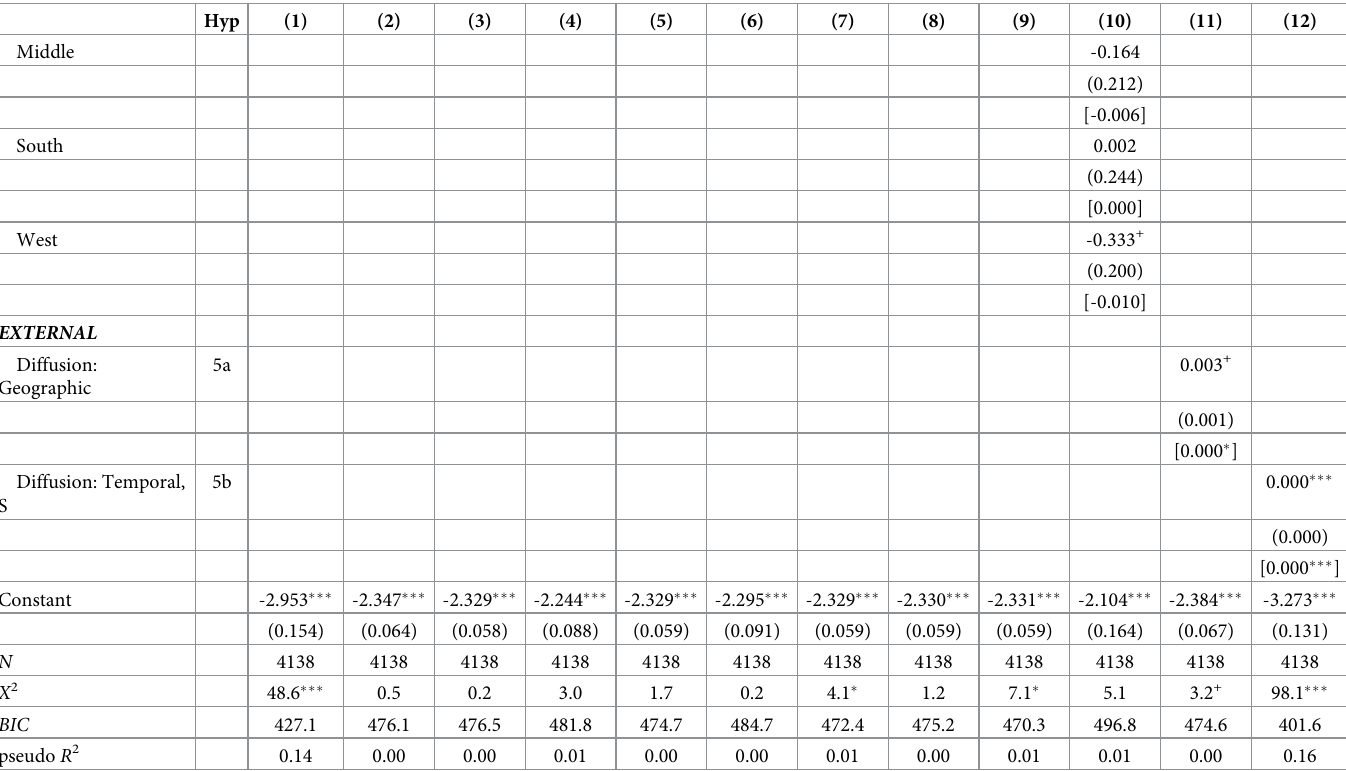
Model 1 using alternative measures. The models include 4,138 country-days. Each model is statistically significant. Model fit ranges from BICs of 485 to 529 and pseudo R 2 s from 0.21 to 0.26. The estimates are based on robust standard errors due to evidence of heteroskedasticity, and all p-values are based on two-tailed tests. Tests suggest that collinearity is not unduly affecting the regression coefficients or standard